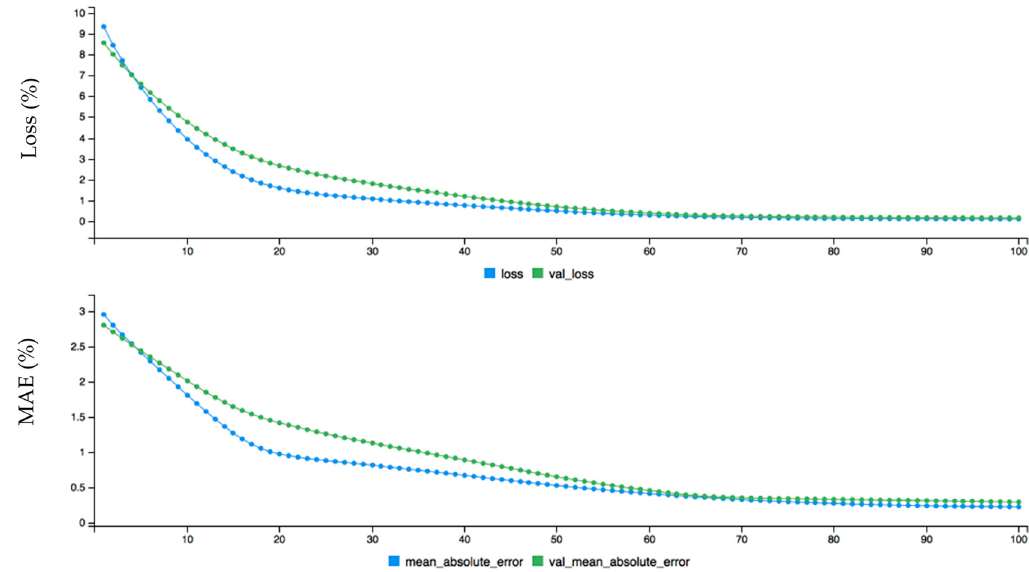
Figure 9. The dynamic plot of forecasting error before fine-tuning configuration for hourly wind data.